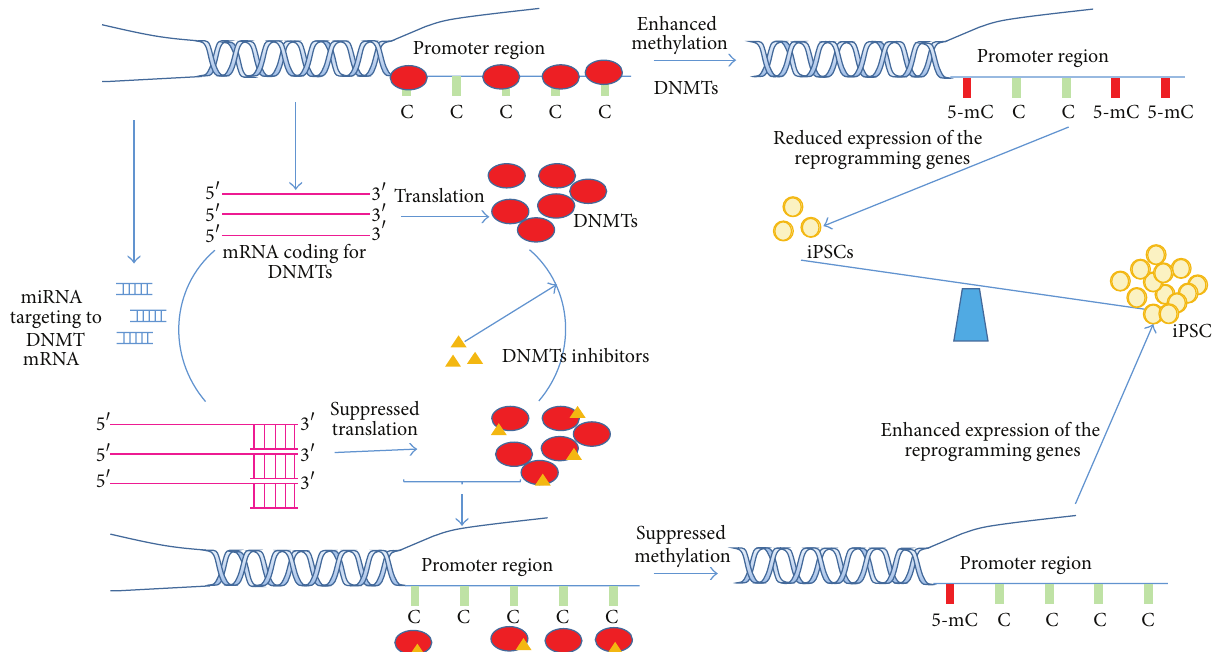
Figure 3: Regulation of the dynamic balance between methylation and demethylation by miRNA and small molecules functions as DNMTs inhibitors. Some miRNA targeted the mRNA coding for DNMTs and some small molecules function as inhibitors of DNMTs. Due to overexpressionofsomemiRNAspecificallytargetingtoDNMTsmRNAaswellastreatmentwithDNMTsinhibitors,methylationisrepressed, leading to dynamic alteration of methylation and demethylation balance and enhancing the reprogramming